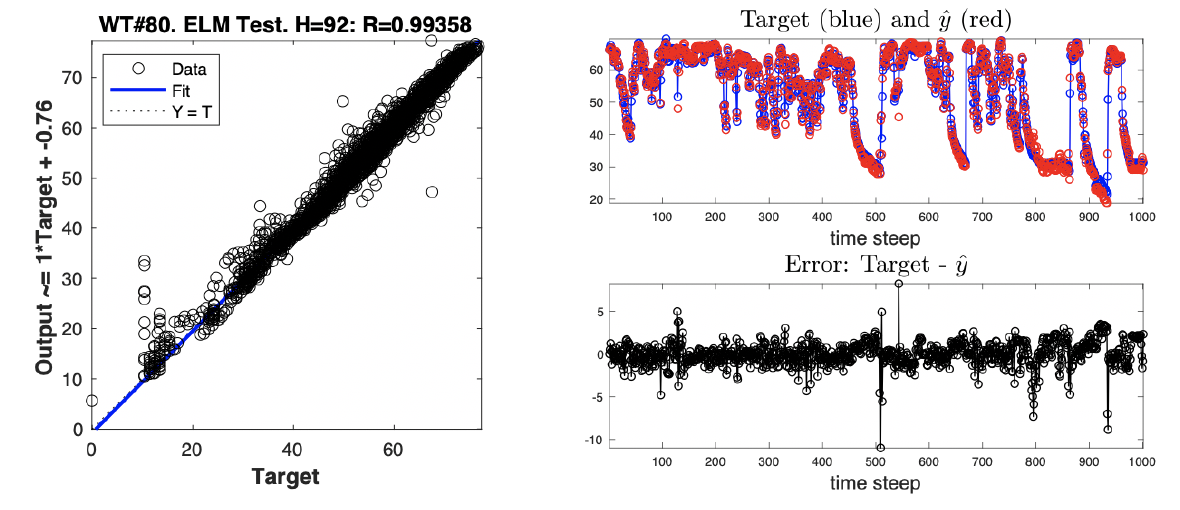
Figure 8. Test of the selected model ( H = 92) for the WT#80. ( Left ) the regression plot using all the test data. ( Right ) from a temporal window where the target ˆ y ( top ) and the error ( bottom ) can be observed in more